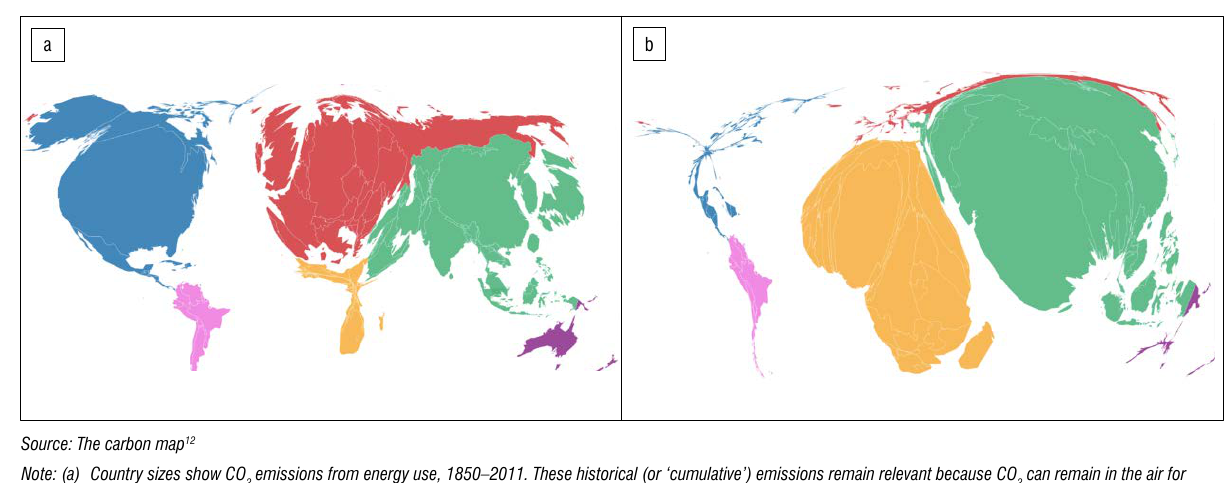
figure 1: Income inequality in South Africa and across selected countries by ventile.